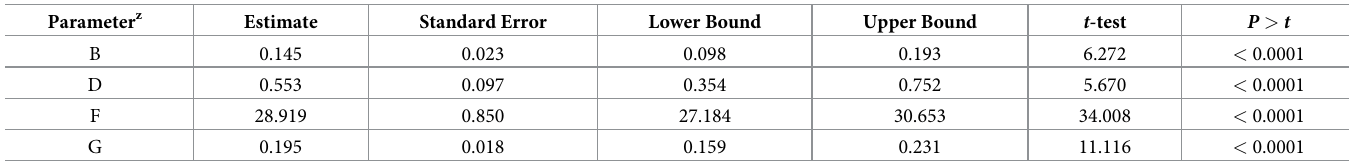
Table 3. Estimated parameter values of the reduced form of Duthie’s model, Eq 5, describing the relative disease severity ( S ’) caused by Xanthomonas arboricola pv. pruni on peach-almond hybrid GF-677 plants based on combined effects of temperature ( t ) and duration of leaf wetness ( w ). In the